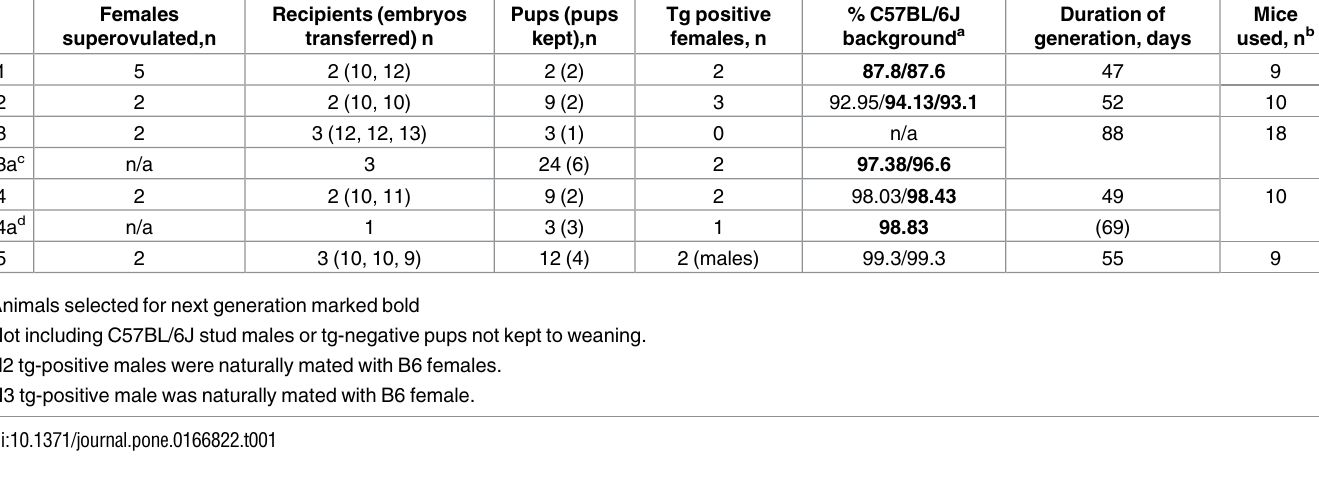
Recipients (embryos transferred)